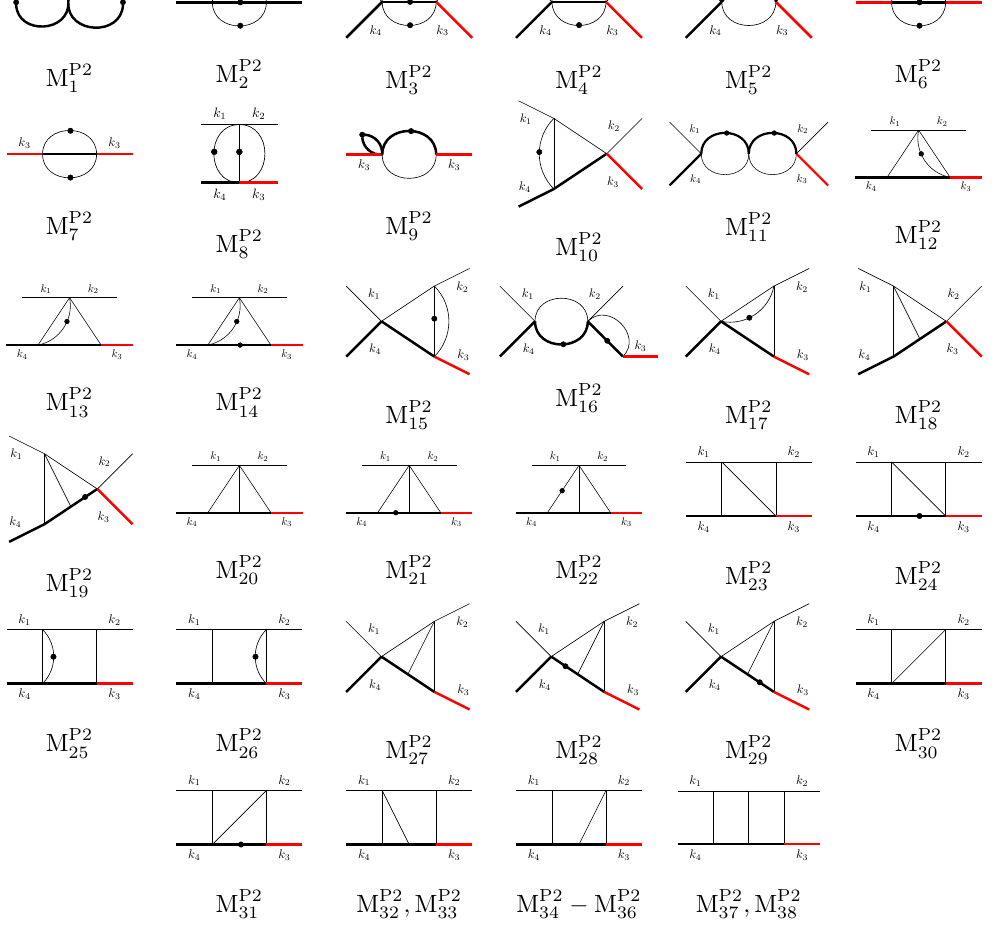
Figure 5. Master integrals in the P2 topology. The thick black and red lines stand for the top quark and W boson, respectively. One black dot indicates one additional power of the corresponding propagator. The numerators can be found in the